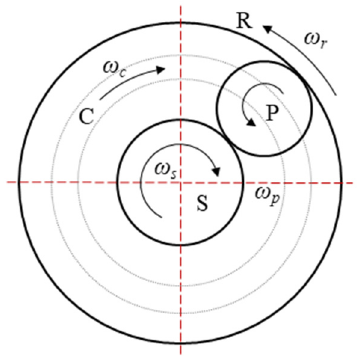
Figure 2. Kinematic diagram of the S-PGT.